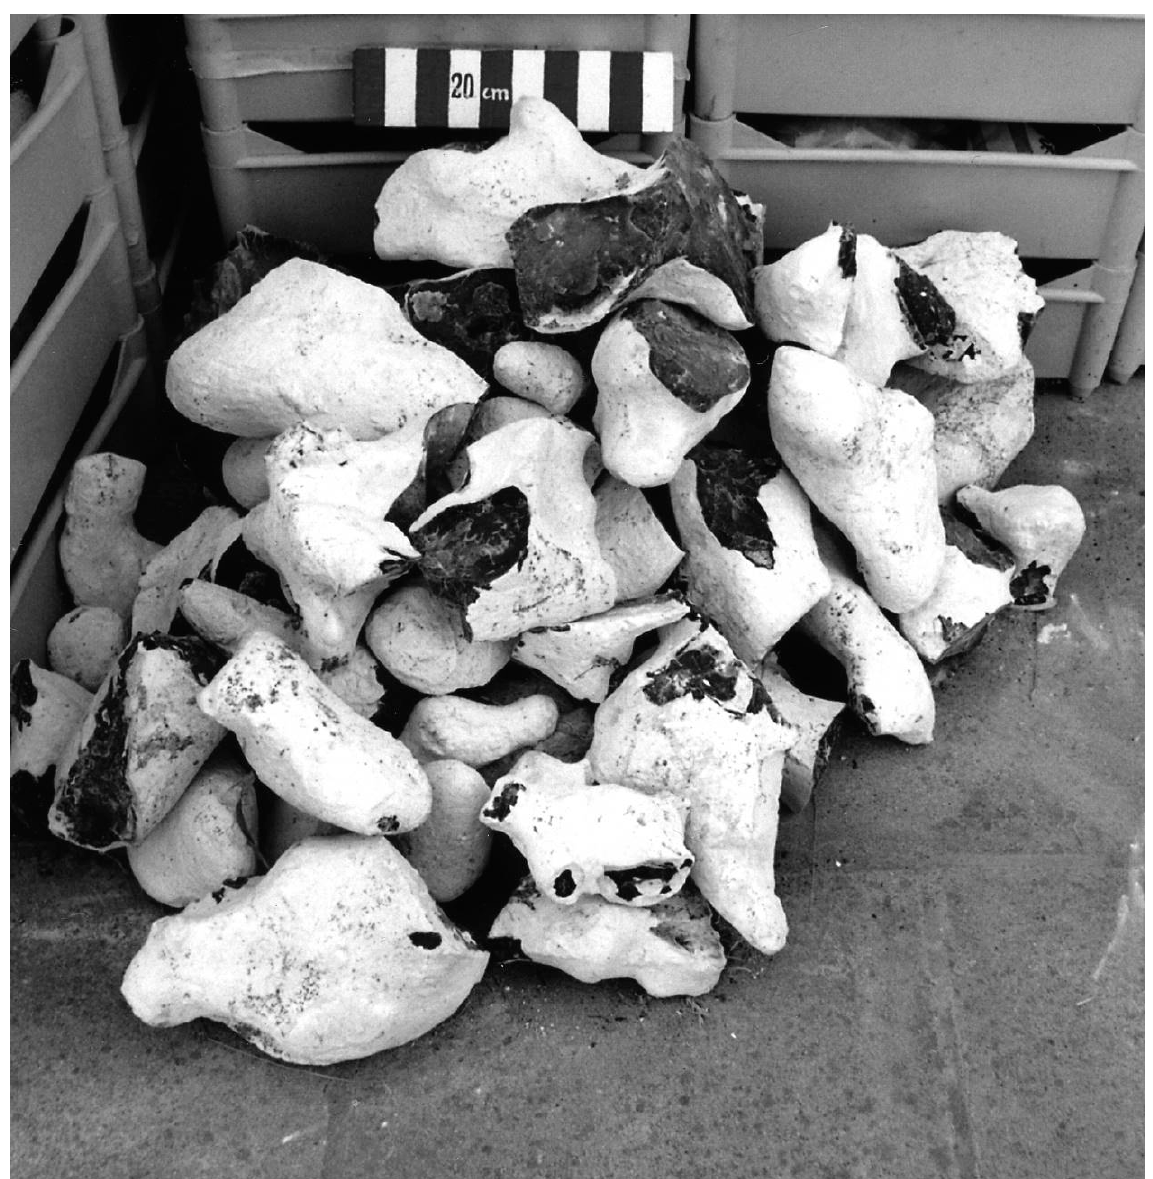
Figure 8. Spiennes. Examples of rejected nodular flint in the ST20 shaft of Petit-Spiennes, 1999-2004 excavations. Photo by J.